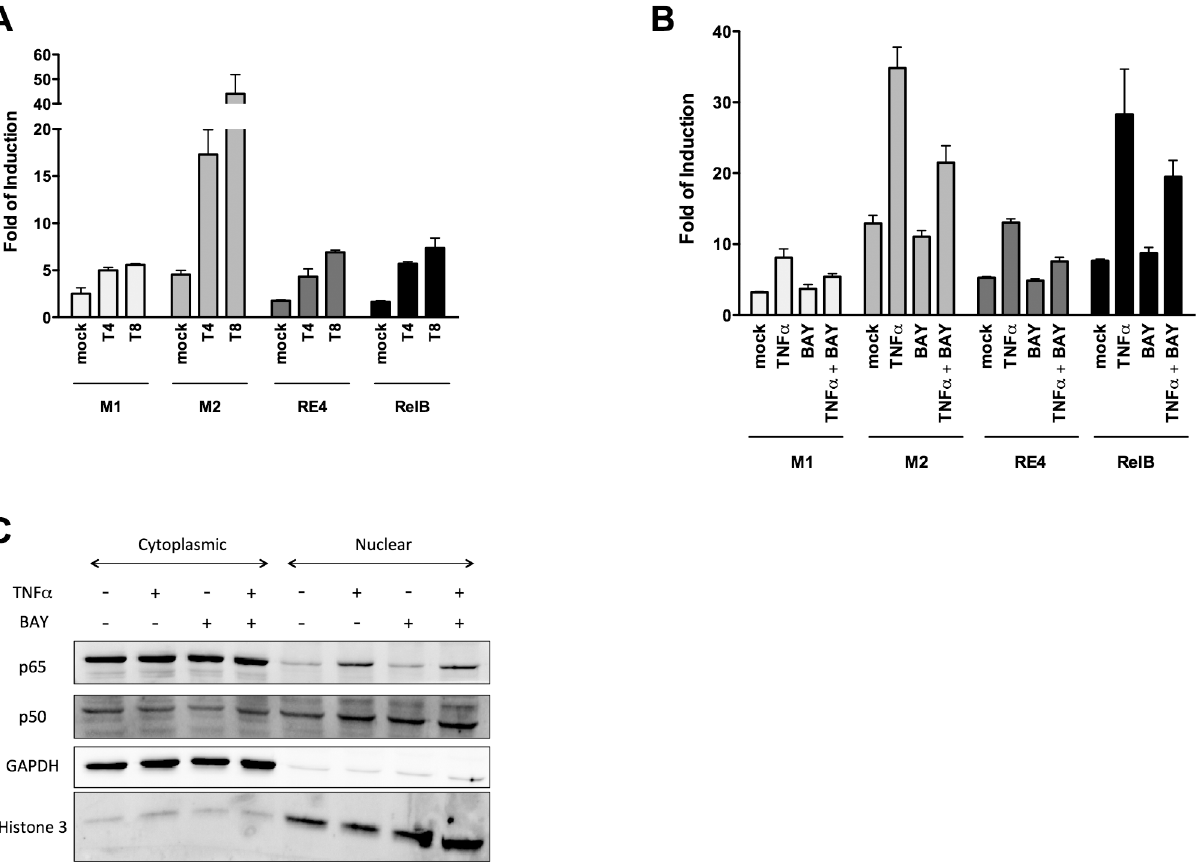
Fig 4. Functional evaluation of four selected κ B-REs in MCF7 cells. A-B) MCF7 cells were transiently transfected with four pGL4.26 derived vectors containing different κ B-REs along with a control pGL4.26 empty vector. Twenty-four hours after transfection cells were treated for 4 or 8 hours with TNF α (10ng/ml for panel A or 50ng/ml for panel B) alone or in combination with BAY11-7082 (20 μ M for 8 hours, only for panel B). Presented are the average fold- induction relative to the empty pGL4.26 vector and the standard deviation of at least three independent biological replicates. C) Western blot analysis showing p50 and p65 protein levels from nuclear-cytoplasmic fractions after the indicated treatments at the following doses: TNF α (50ng/ml) and BAY11- 7082 (20 μ M). GAPDH and Histone 3 were used as reference controls for the cytoplasmic and nuclear fraction respectively.